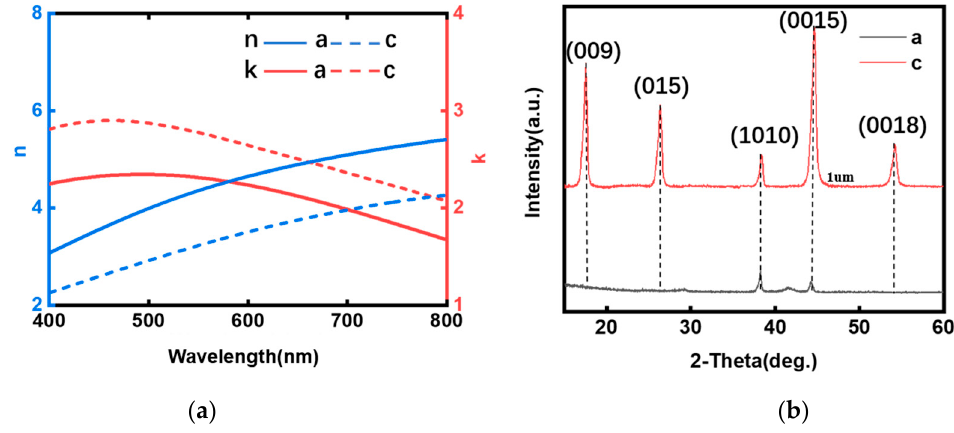
Table 1. Optical material parameters for the simulation.